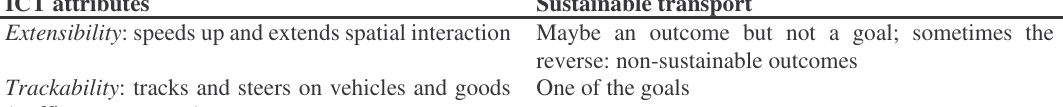
Table 1. Attributes of ICT and transport sustainability in a wider context ICT attributes Sustainable